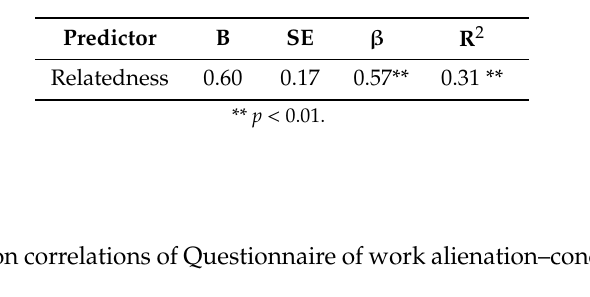
Table 3. E ff ects of satisfaction of need for relatedness on work alienation.